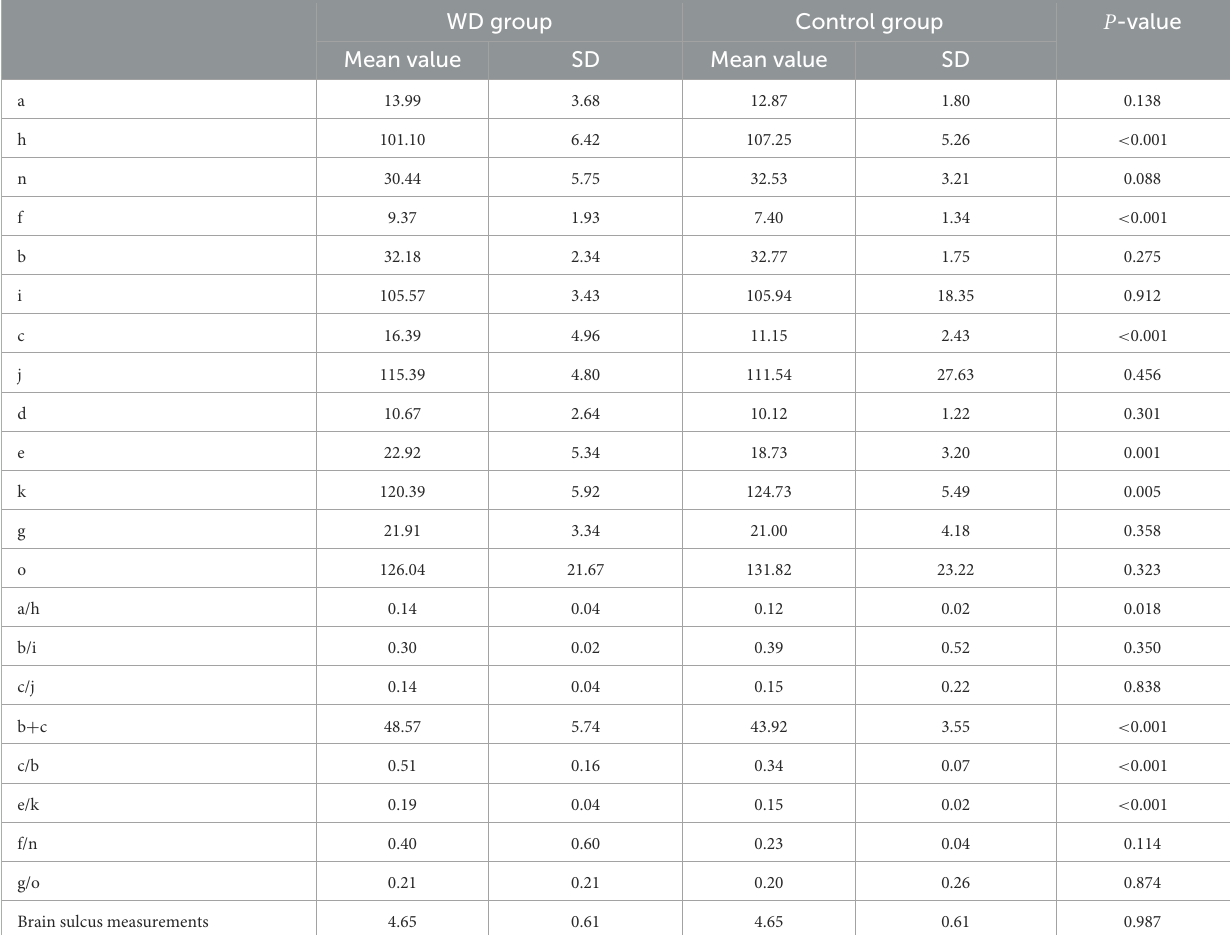
TABLE 2 Linear measurement indicators of brain atrophy in WD patients and healthy controls. WD group Control group P